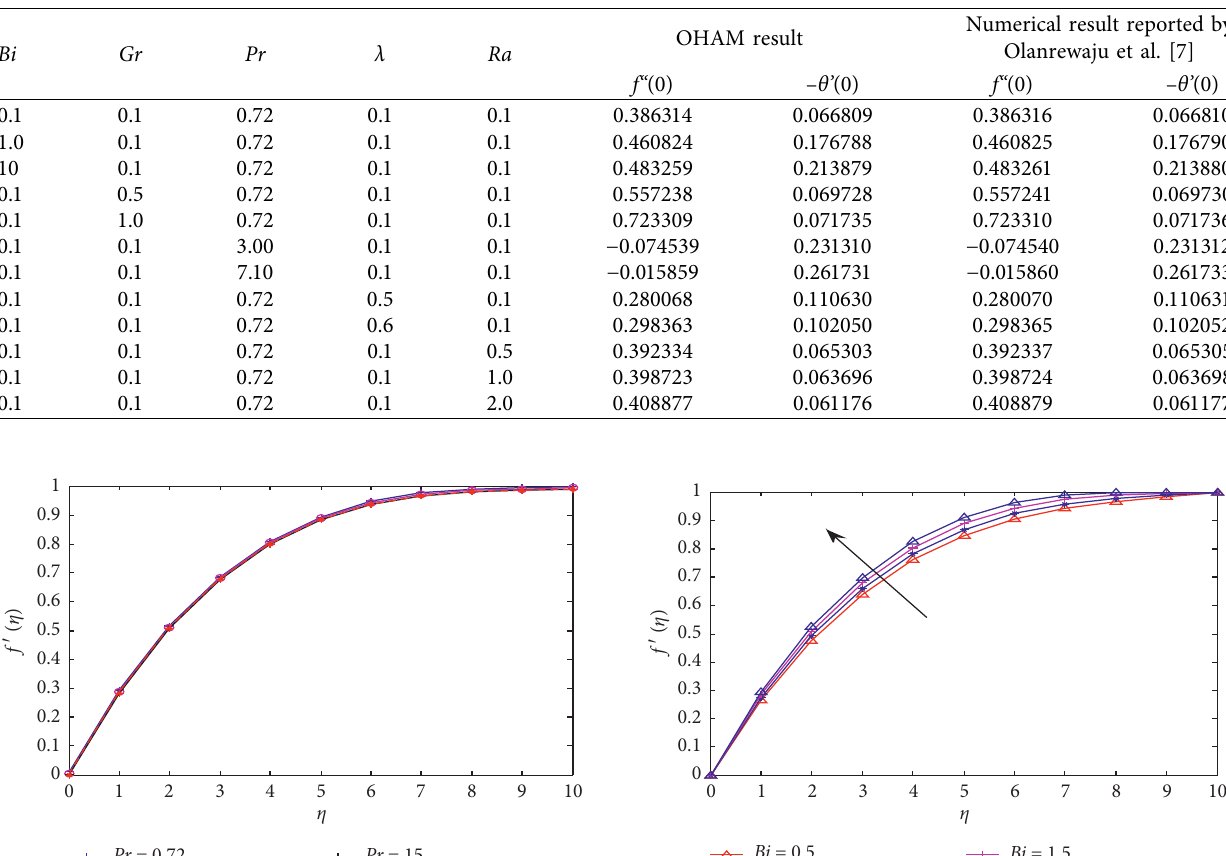
Table 2: A comparison of values of the skin-friction coefficient and the Nusselt number obtained by the OHAM in the present study and numerical solutions reported by Olanrewaju et al. for various parameter values entrenched in the flow model.